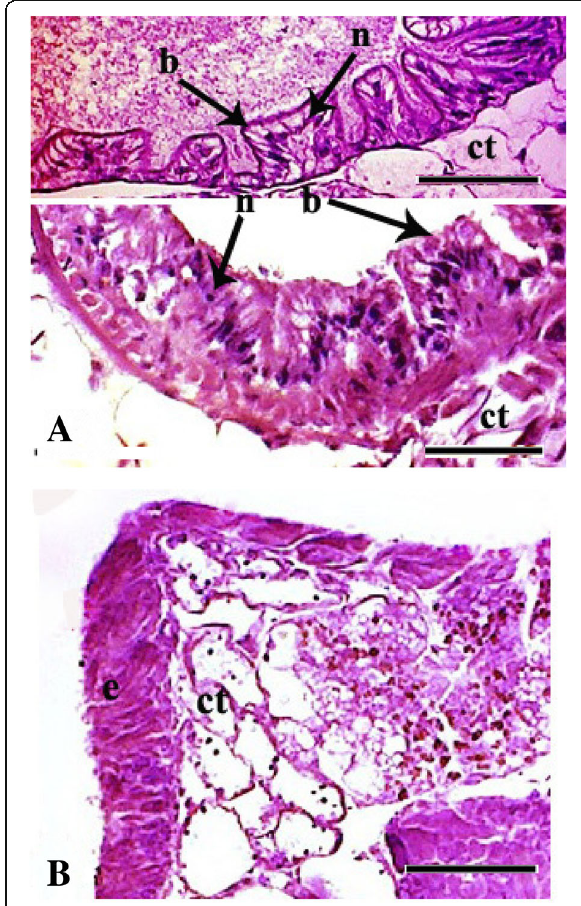
Fig. 6 A , B Photomicrograph of the intestine of Monacha obstructa showing A presence of a brush border covering the epithelial lining (above) (b), and nuclei are regularly arranged (n). After exposure to UV-A for 3 h for 2 days (below) showing irregular arrangement of nuclei (n) and absence of the brush border (b). B Snails exposed to UV-A for 3 h for three successive days suffered from destruction of both the epithelial tissue (e) and the connective tissue